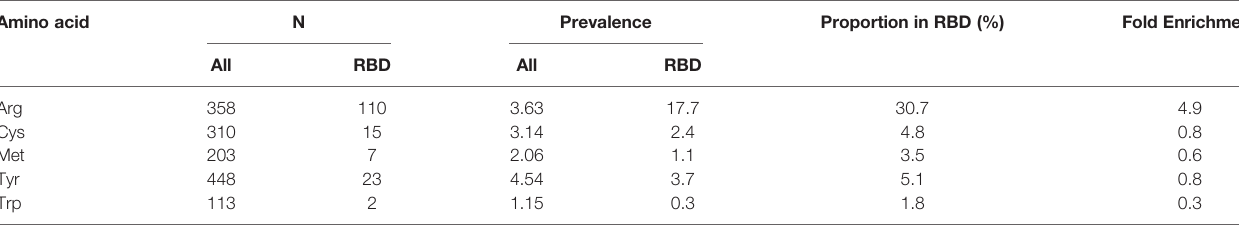
TABLE 1 | Receptor binding domain of SARS-CoV-2 viral proteomes. Amino acid N